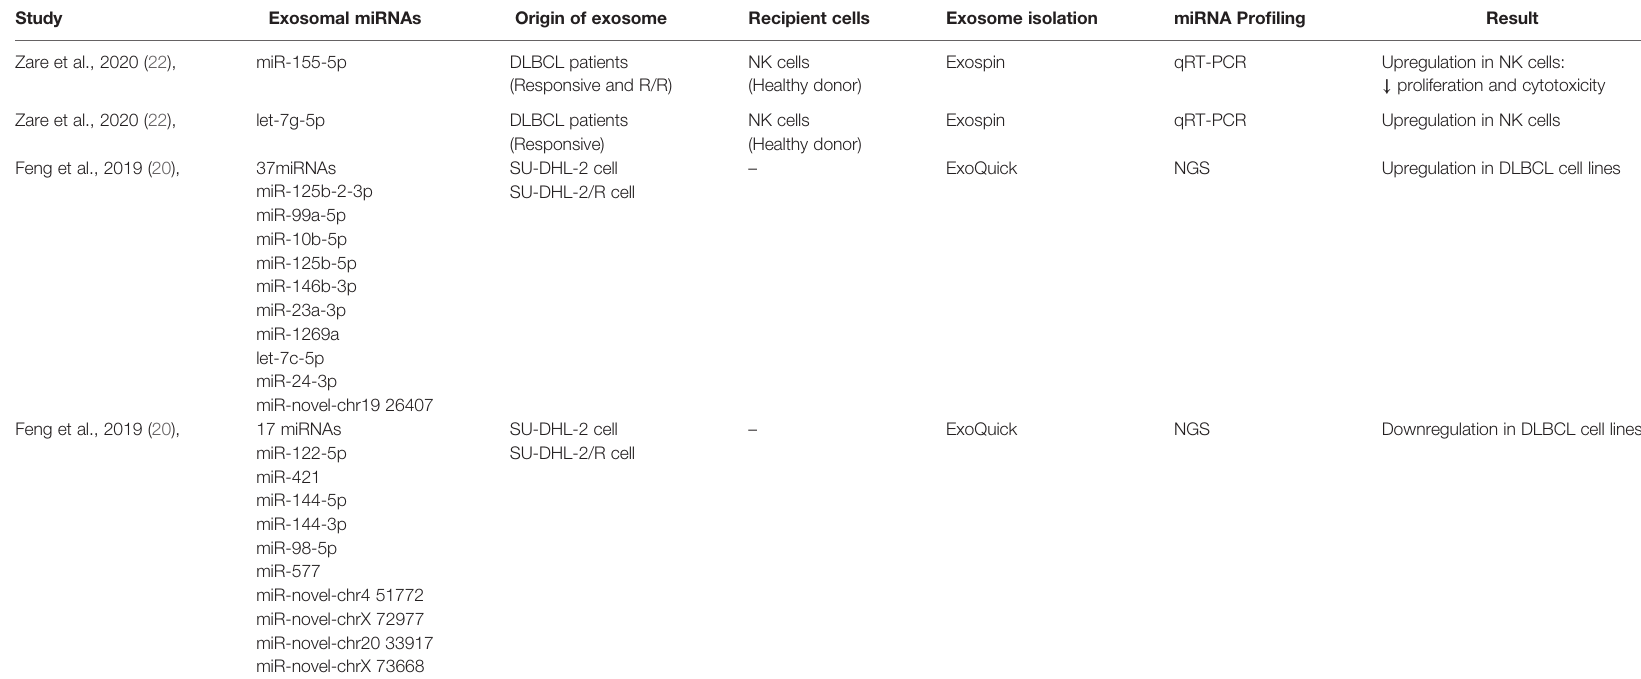
TABLE 6 | In vitro study of exosomal miRNA in